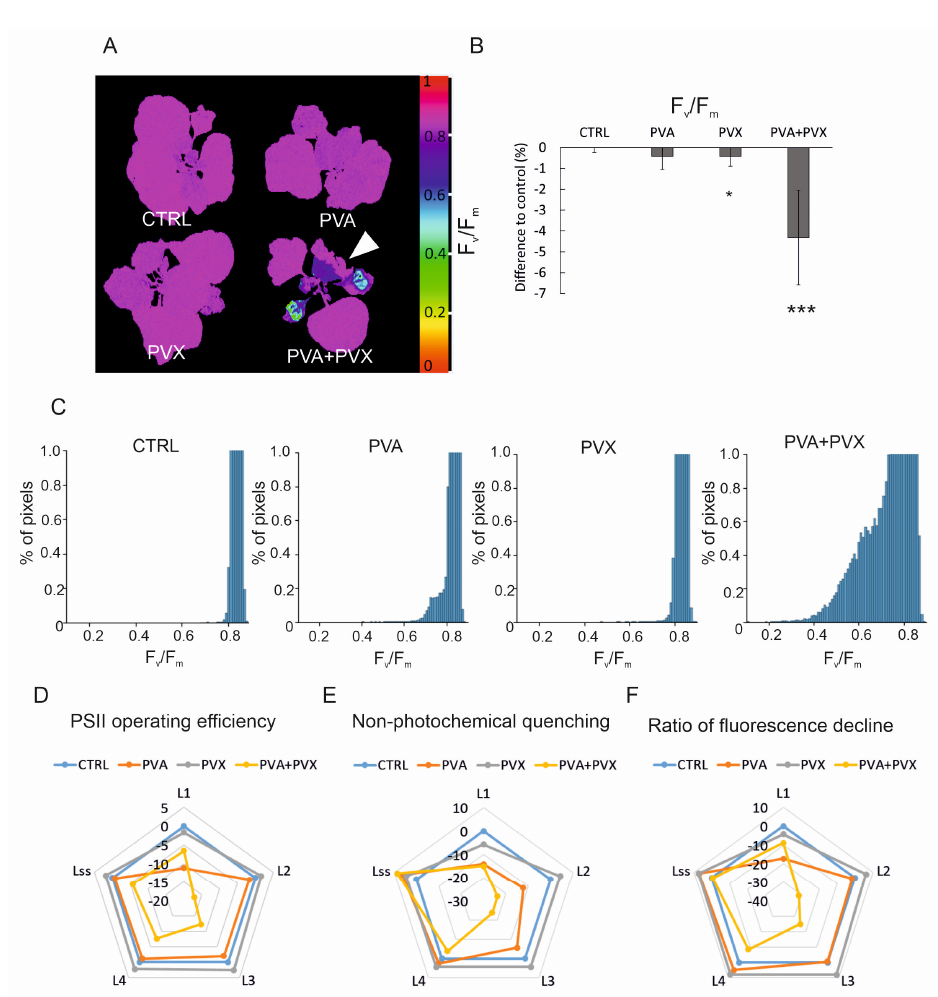
Figure 3. PVA + PVX co-infection lowers photosynthetic performance. ( A ) F v /F m , maximum PSII quantum yield in selected plants. A white arrow indicates a systemic leaf with low F v /F m in the PVA + PVX co-infected plant. False color images were created by normalizing to RGB values and percentage decrease was calculated from Fluorcam whole plant image data.( B ) Average percentage decrease in F v /F m compared to healthy control plants (* p < 0.05, *** p < 0.001). ( C ) Dispersion of F v /F m pixel values representing maximum PSII quantum yield in the control and single and mixed PVA and PVX infections at 10 dpi. The X -axis was limited to represent 1% of total counts to magnify the F v /F m value dispersion below threshold. ( D ) PSII operating efficiency ( Φ PSII), ( E ) non-photochemical quenching and ( F ) ratio of fluorescence decline during light adaptation (L1–L4) and light-adapted steady state (Lss) at 10 dpi in control, PVA, PVX and co-infected plants. Average percentage differences compared to the control are shown from one phenotyping experiment.